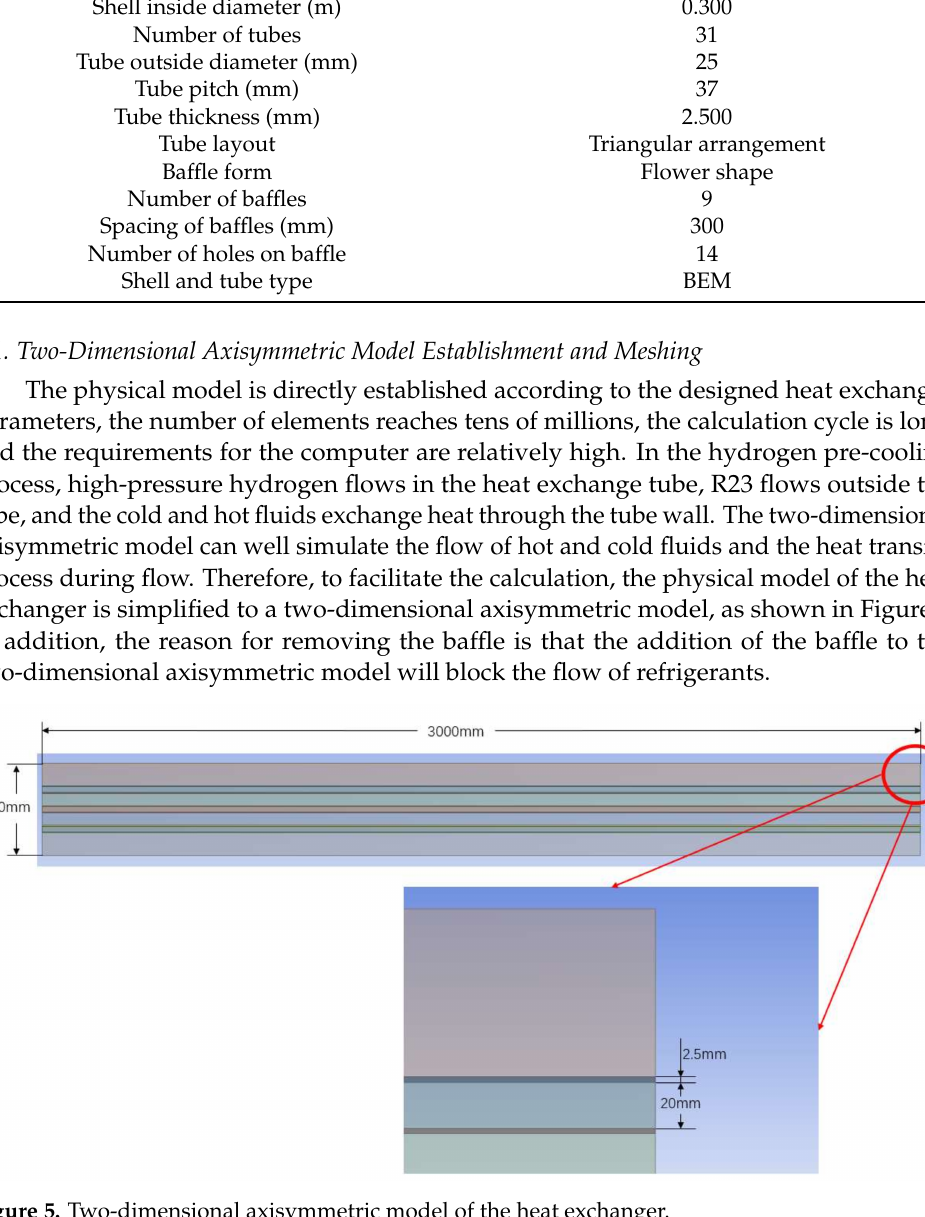
Figure 5. Two-dimensional axisymmetric model of the heat